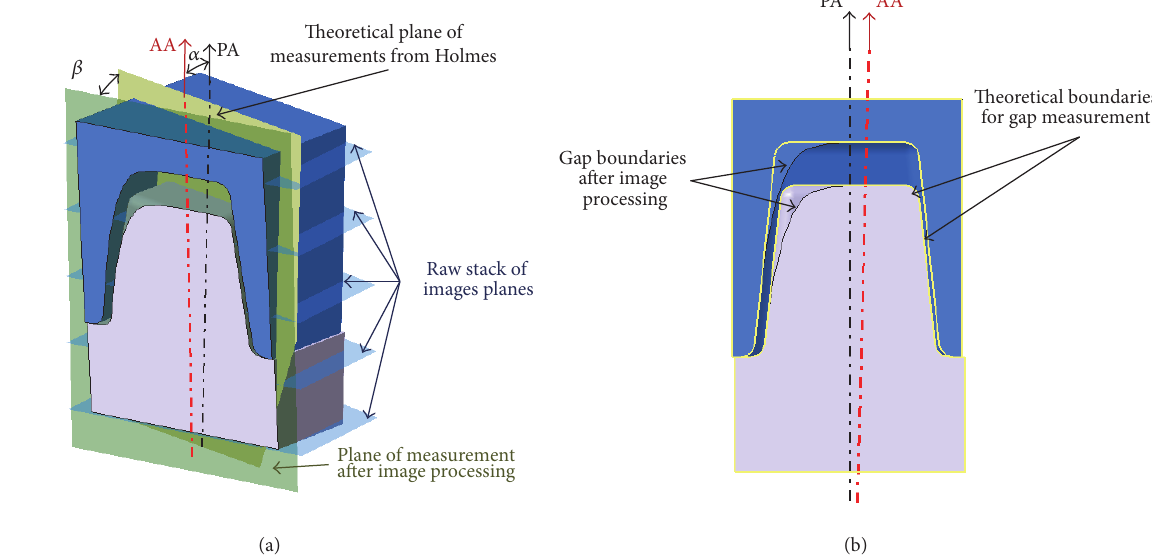
Figure 9: 3D simulation of errors occurring during CT scan acquisition and image postprocessing for pyramidal assembly (a) detailed errors; (b) overlay of theoretical and simulated image